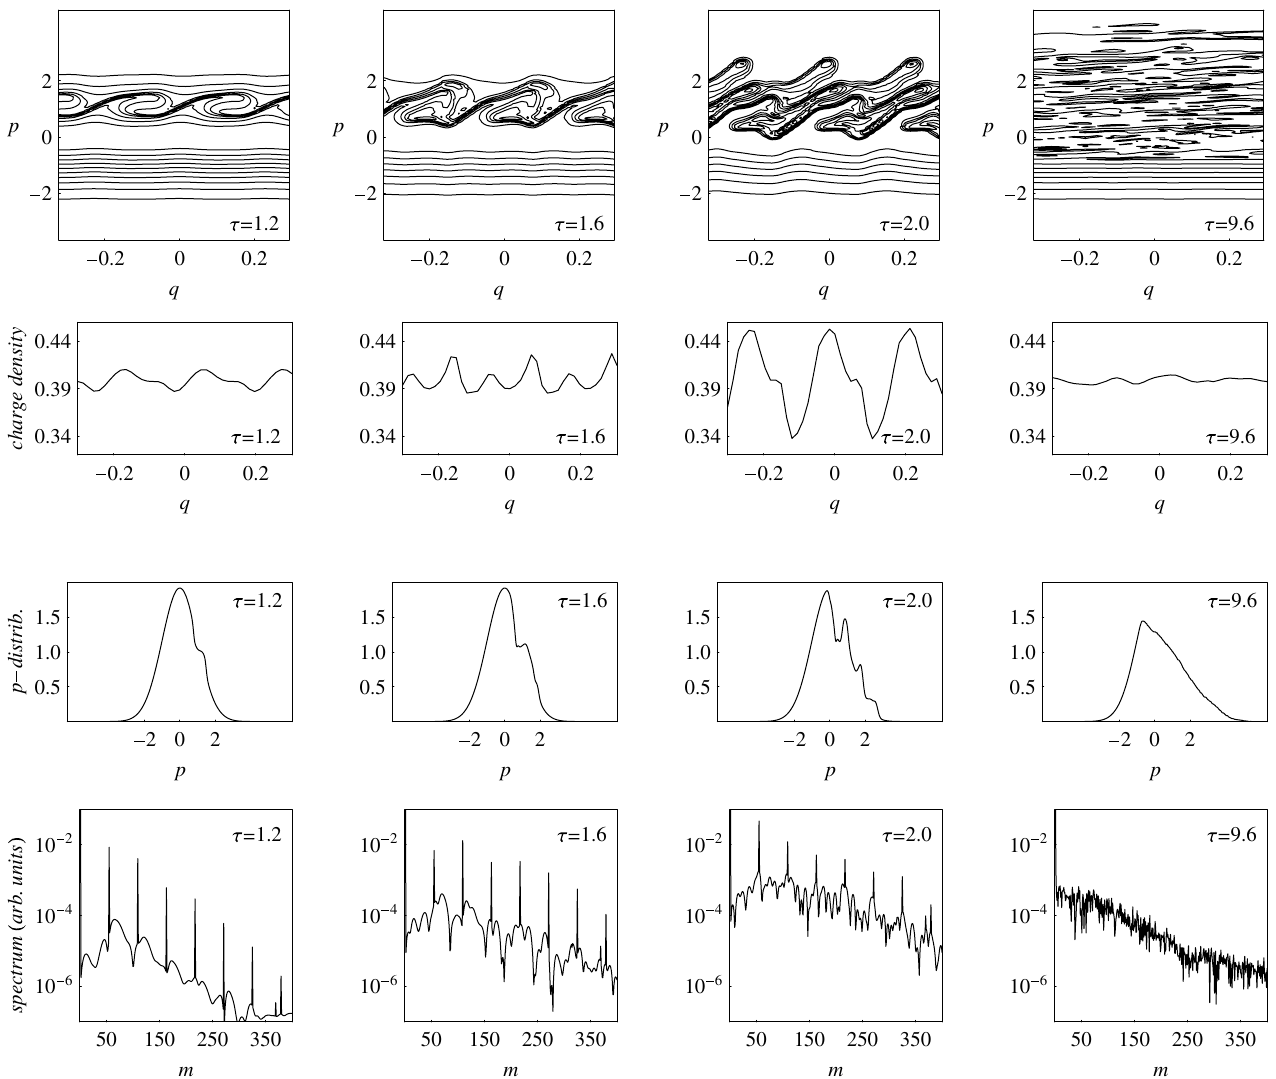
FIG. 4. Evolution in time of coasting beam by effect of CSR. Instability initiated by a small perturbation with mode number n (cid:2) 702 (wavelength (cid:4) (cid:2) 2 : 2 mm ). From top to bottom: snapshots of contour plots of phase space density (top row), charge density (second row), momentum distribution (third row), and spectrum of charge density (bottom row). Pictures are taken at (normalized) time (cid:2) 1 : 2 , 1.6, 2.0, and 9.6. In the bottom row the abscissa is m (cid:2) n= 13 , where n is the mode number (see text). The plots in the top two rows show only a small part of the full grid in q